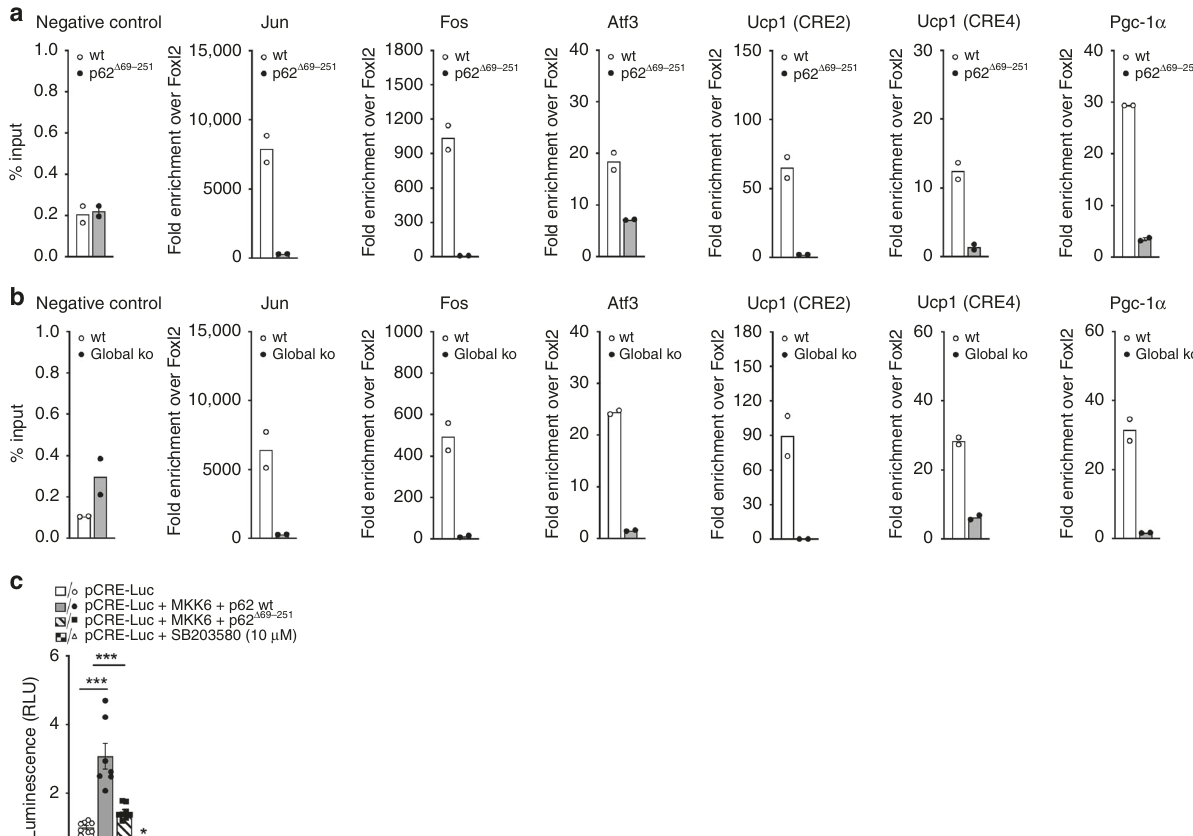
Fig. 7 Impaired genomic binding of ATF2 in p62 Δ 69-251 and global p62 − / − mice. Chromatin immunoprecipitation (ChIP) in BAT of male wt and p62 Δ 69-251 mice ( a ) and p62 − / − mice ( b ) using antibodies speci fi c for ATF2. ChIP-qPCR analysis of Foxl2 (negative control), Jun , Fos , Atf3 , Ucp1 (CRE2) , Ucp1 (CRE4) , and Pgc-1 α ( n = 5 mice pooled each genotype, n = 2 technical replicates) ( a , b ). Luciferase-based CRE reporter assay of HEK293T cells transfected with the pCRE- Luc reporter, a dominant positive MKK6 (K82A) and p62 wt or p62 Δ 69-251 ( n = 7/8 technical replicates each group) ( c ). Panel ( c ) is a representative example of three independently performed studies, each yielding similar results. Data in ( a ) and ( b ) have been analyzed using a two-sided two-tailed t -test, data in ( c ) have been analyzed using one-way ANOVA was treatment as co-variant and using Bonferroni multiple comparison between the treatment groups. Data represent mean±SEM. * p <0.05; ** p <0.01; *** p <0.001. Exact p -values are ( c ) pCRE-Luc vs. pCRE-Luc + MKK6 + p62 wt p <0.0001, pCRE-Luc vs. pCRE-Luc